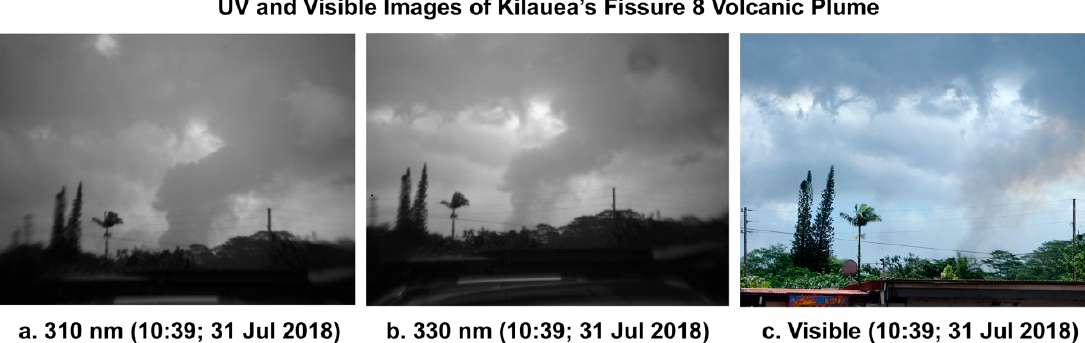
Figure 19. The darkened tint of UVR images ( a , b ) clearly reveal the presence of significant SO 2 in the volcanic plume emerging from Kilauea’s Fissure 8. Aerosols alone are responsible for the visibility of the plume in the visible image ( c ).